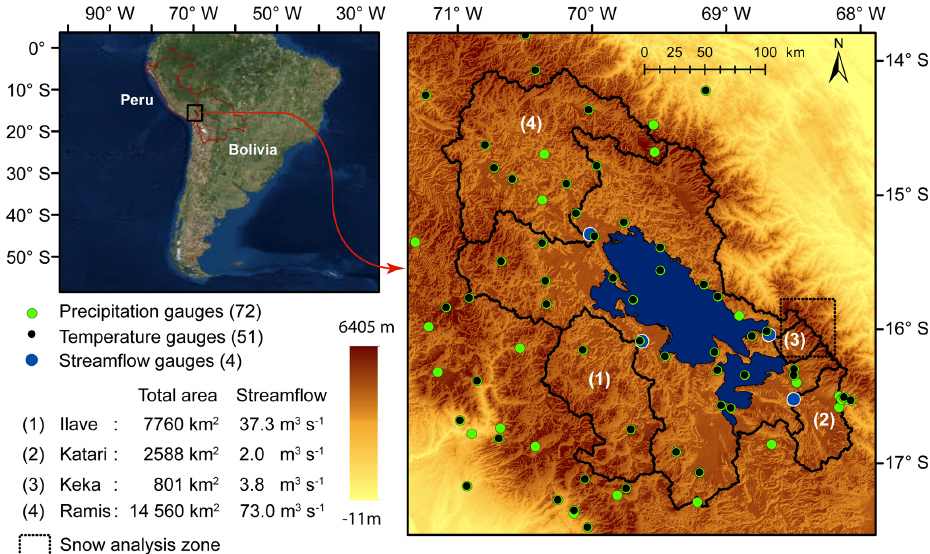
Figure 1. Study area: location, meteorological stations (precipitation and temperature observations), streamflow gauges, studied catchments and snow analysis